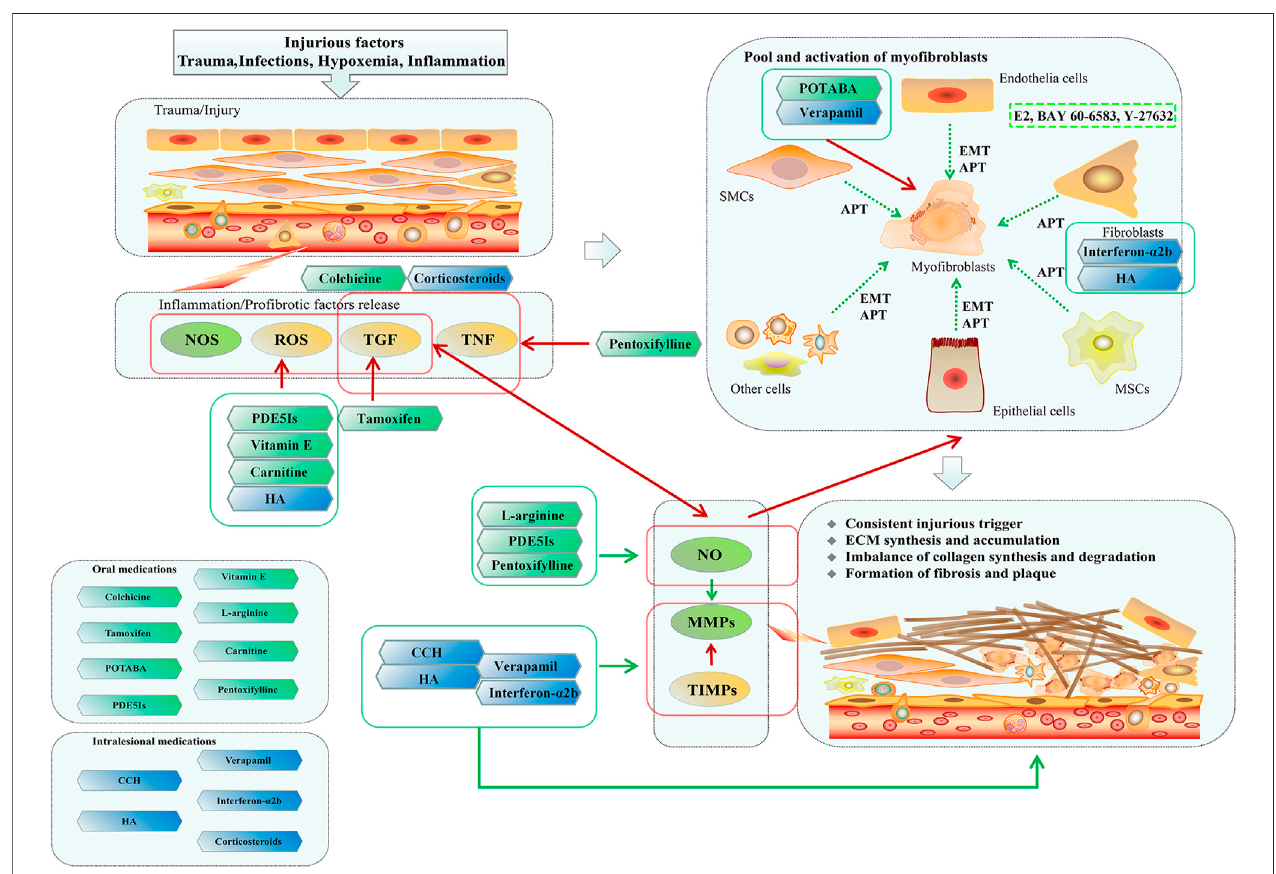
FIGURE 1 | Possible mechanisms of Peyronie ’ s disease and pharmacotherapeutic therapies. Due to the injurious factors were not removed timely, consistent injurious trigger result in chronic in fl ammation and the release of pro fi brotic factors, such as TGF, ROS, and TNF. Furthermore, these events induce phenotype transformation from potential precursors to myo fi broblasts, and subsequently imbalance of collagen synthesis and degradation. Finally, the persistent accumulation of ECM leads the formation of penile fi brosis and plaque, causing penile deformation and dysfunction. In clinical practices, pharmacotherapy remains an important part ofcombinationregimenforPeyronie ’ sdisease. VitaminE,Carnitine,PDE5Is,L-arginine andHAwerereportedtobebene fi cialtoquenchtheROS.Tamoxifen might have the anti- fi brotic effects by inhibiting secretion of TGF- β 1. Pentoxifylline has anti-in fl ammatory and anti- fi brotic role by increasing NO and inhibiting the TGF- β 1 and TNF. Colchicine could inhibit the in fl ammation and increase collagenase activity. POTABA and verapamil exhibits the anti- fi brotic effect by suppressing the activation of myo fi broblasts. Interferon- α 2b and HA could reduce the proliferation of fi broblasts, and might have the role of immune modulation. Corticosteroids could inhibit